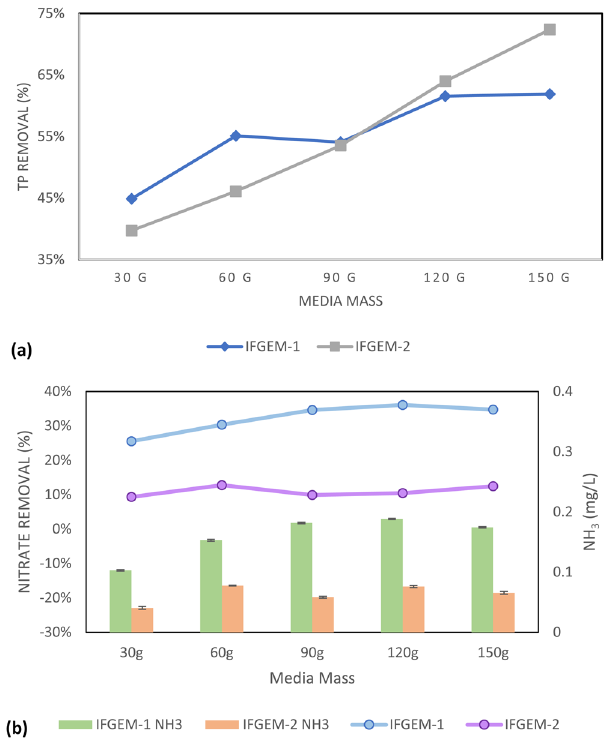
Figure 3. Outcome of the isotherm study: ( a ) the TP removals from the isotherm study of IFGEM-1 and IFGEM-2 under neutral pH condition and ( b ) the nitrate removal and ammonia generation from the isotherm study on IFGEM-1 and IFGEM-2 under neutral pH